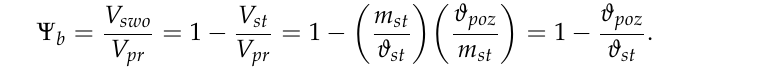
Table 1. Characteristic of research material—sintered porous (polyamide) (author’s own study). Density: Cubic Solid: Indicator Porosity Equivalent Porosity Absolute Pore Diameter Apparent Skeleton